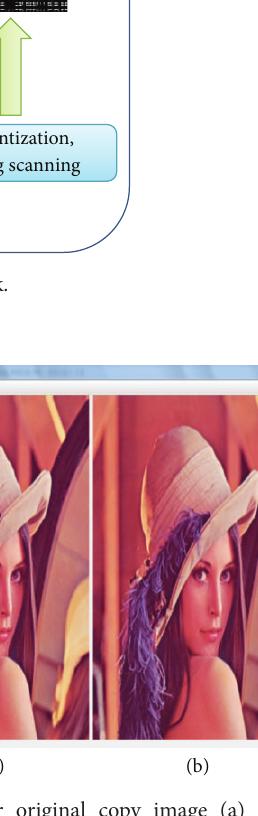
Figure 9: Screen for original copy image (a) and embedded watermark image (b).